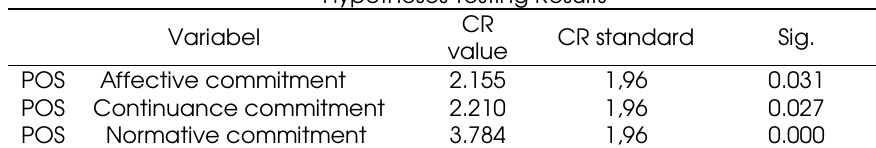
Hypotheses Testing